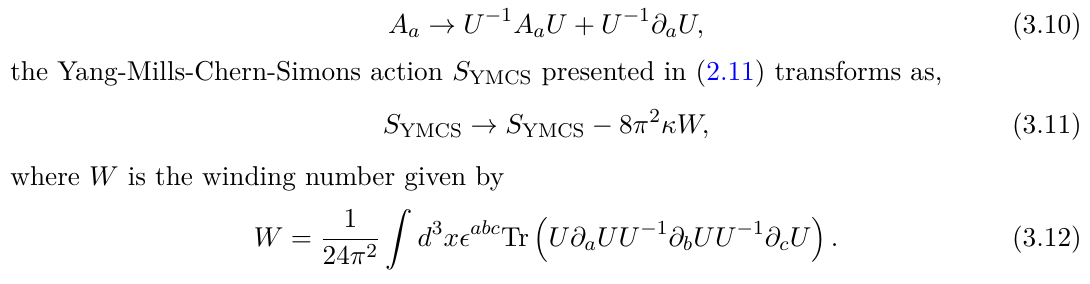
Figure 2 . The vacuum energy for distinct κ . For example for κ = 0 , we have a ∈ κ = 1 , we have a ∈ 4 π